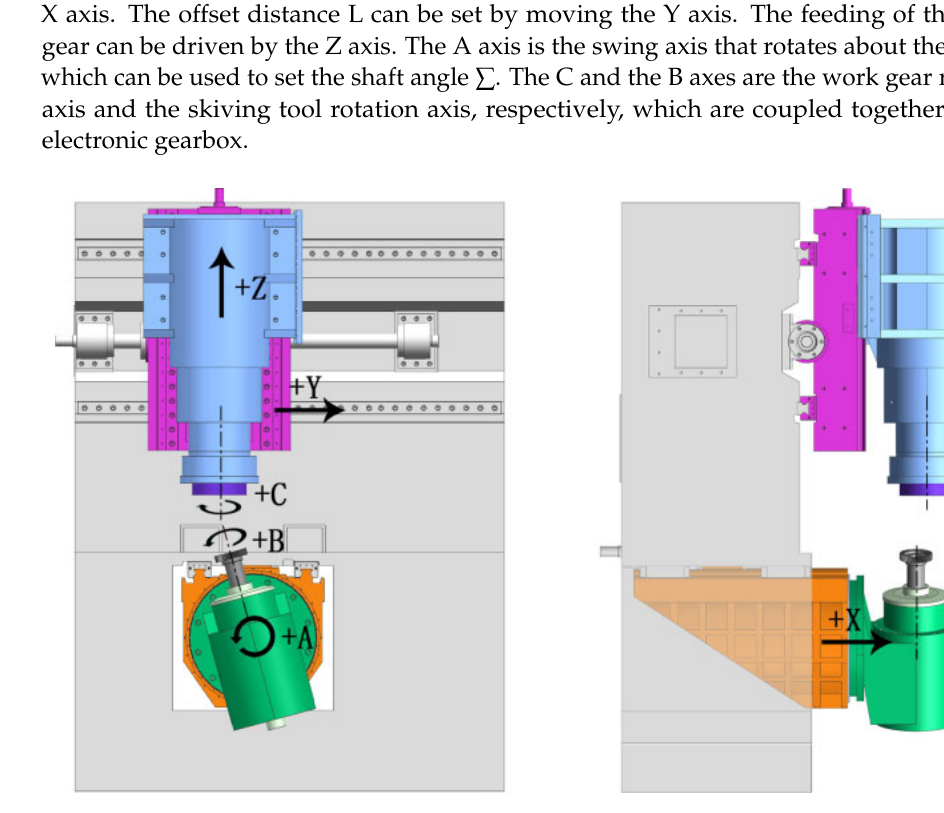
Figure 6. Model of the skiving machine tool.